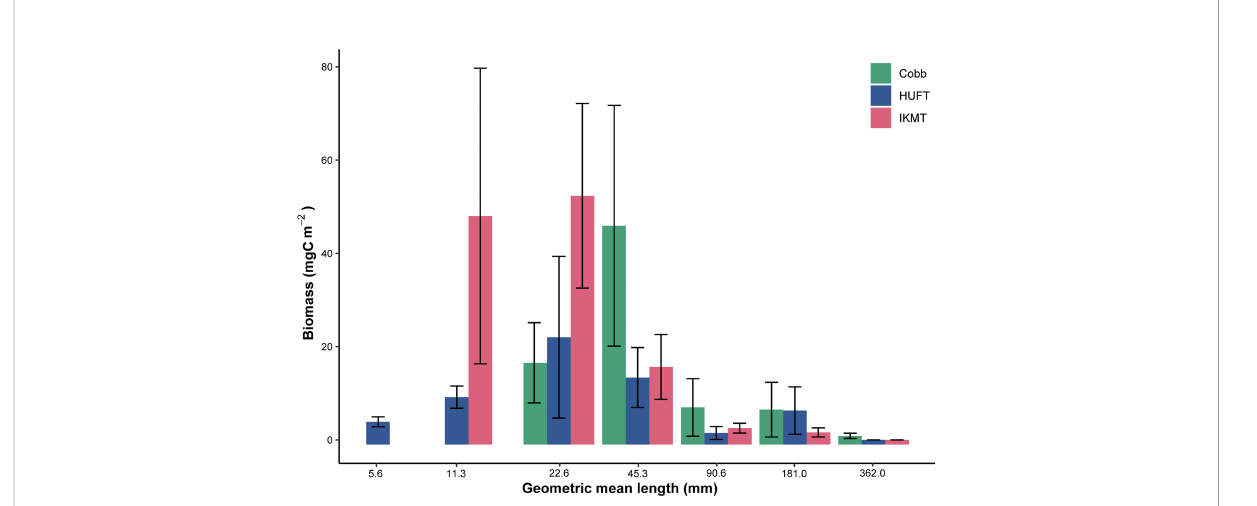
FIGURE 5 Total biomass by geometric mean length for the Cobb, HUFT, and IKMT at night in the epipelagic, October 2004, where biomass is expressed in carbon units and organisms are grouped into log-2 size bins. Bars indicate mean ± standard error of the